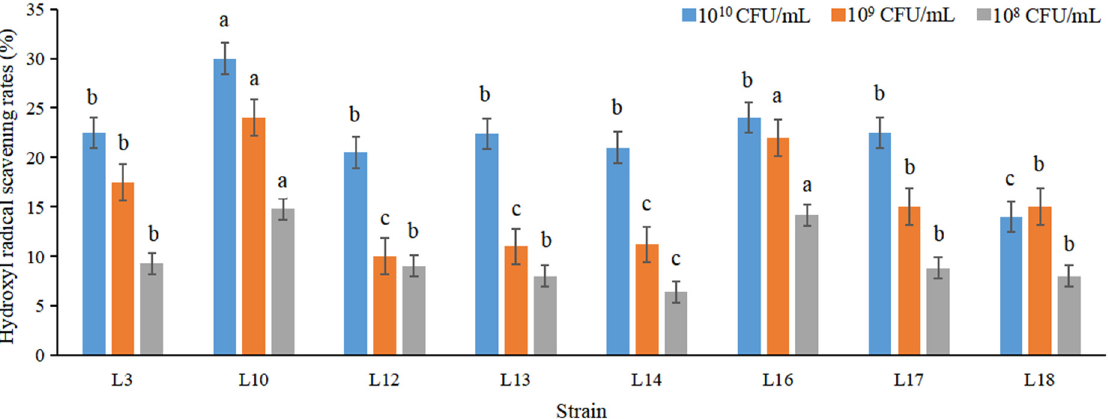
Figure 4. The hydroxyl radical scavenging rate (%) of selected 8 strains. The different letters indicated significant difference among treatments ( p < 0.05).